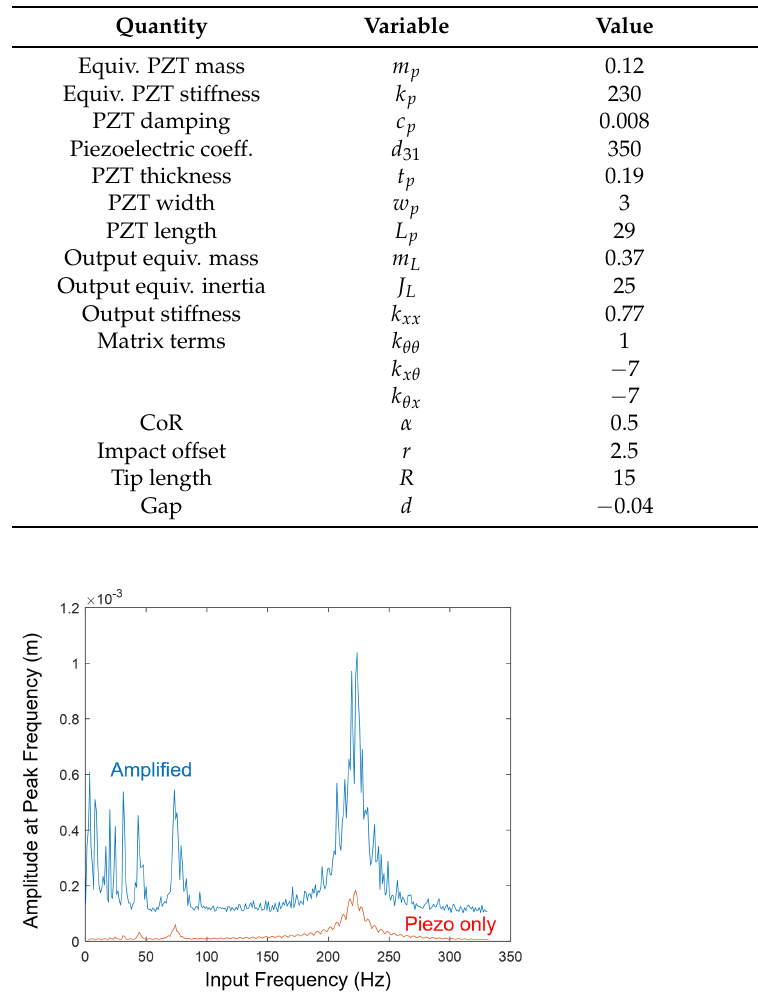
Table 1. Simulation parameters.